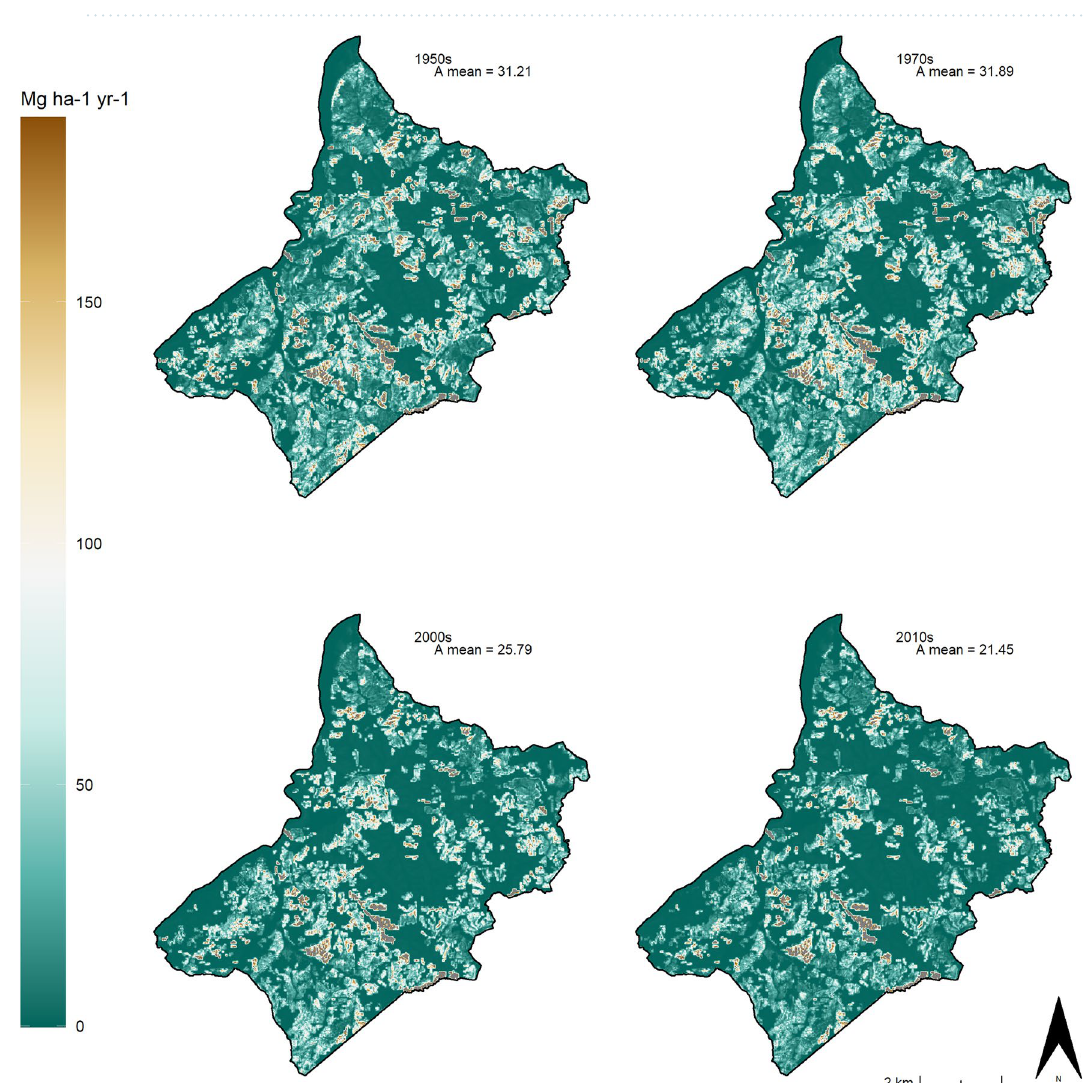
Figure 11. The HLC-RUSLE model calculated for the four chronological periods: 1950s, 1970s, 2000s, 2010s). Image generated with software RStudio Desktop 2022.07.2 + 576 (https:// www. rstud io.